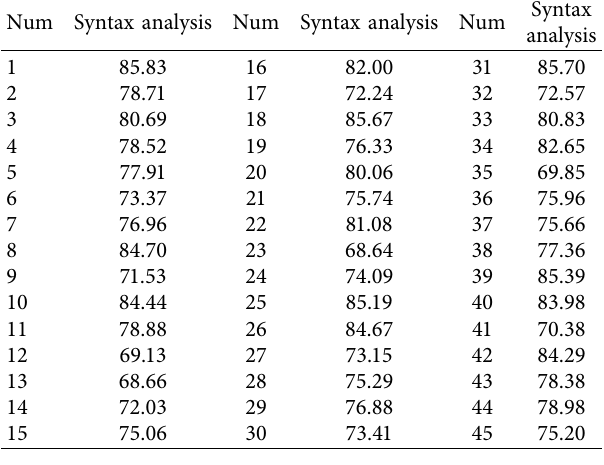
Table 1: Syntactic analysis